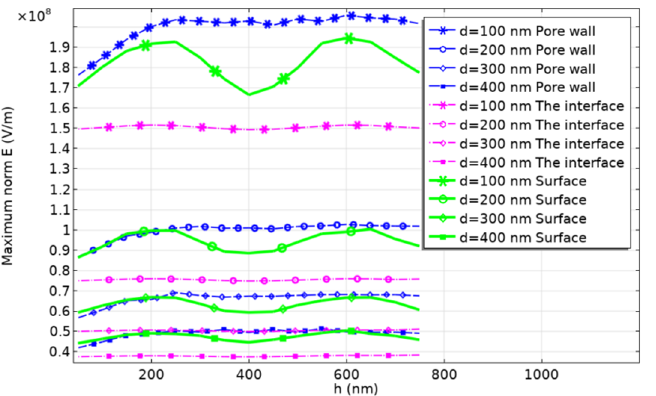
Figure 3. The electric field intensity at the surface of the grating, the hole wall, the interface between the film and the substrate, and the surface when the structure is illuminated from the air in a normal-incidence 1064 nm laser.